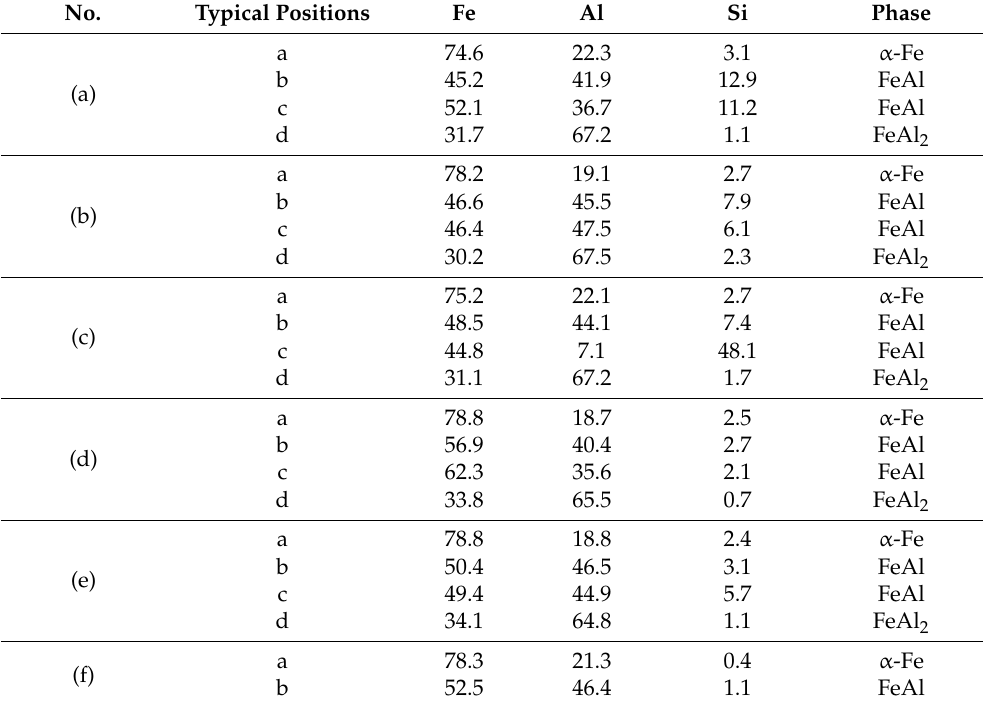
Table 4. Phase Analysis by EDS in Figure 5